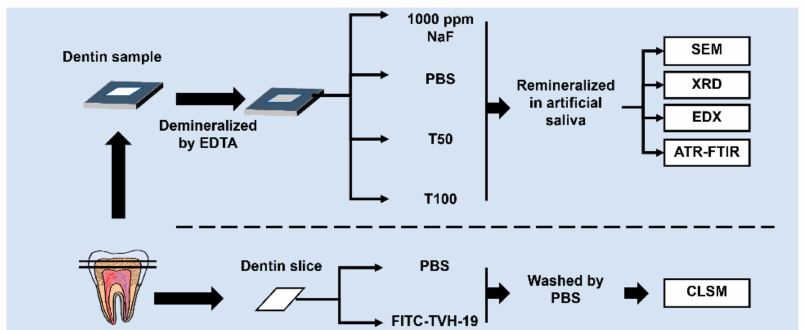
Figure 1. Schematic representation of the design and procedures of the